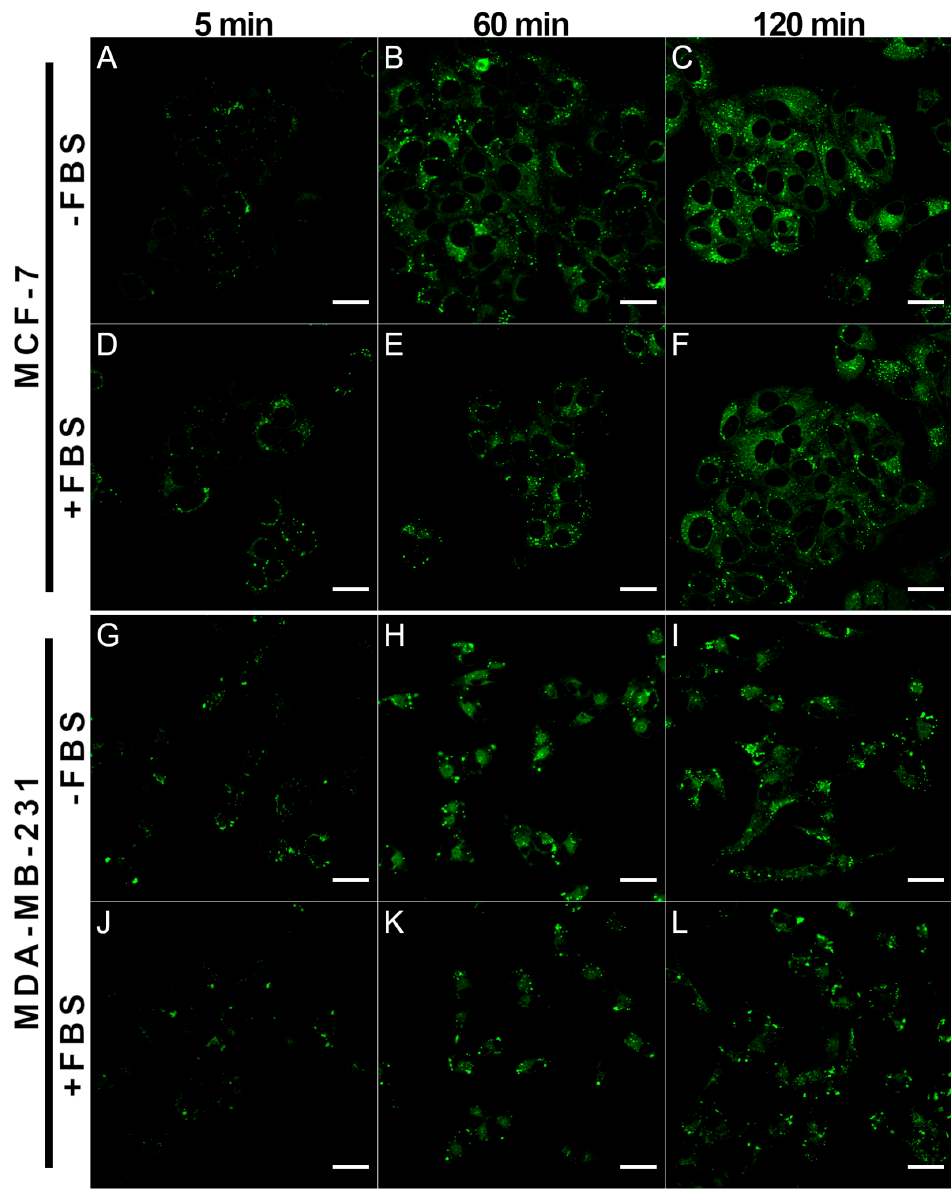
Figure 4. Intracellular distribution of 9 µM BDP-H in live MCF-7 ( A – F ) and MDA-MB-231 ( G – L ) cancer cells. Both cell lines were incubated in PBS without FBS (-FBS) or with 10% FBS (+FBS). Different incubation times with BDP-H (5–120 min) were used. Cells were visualized using laser-scanning confocal microscope; λ ex = 480 ± 5 nm. Scale bars: 30 µm.